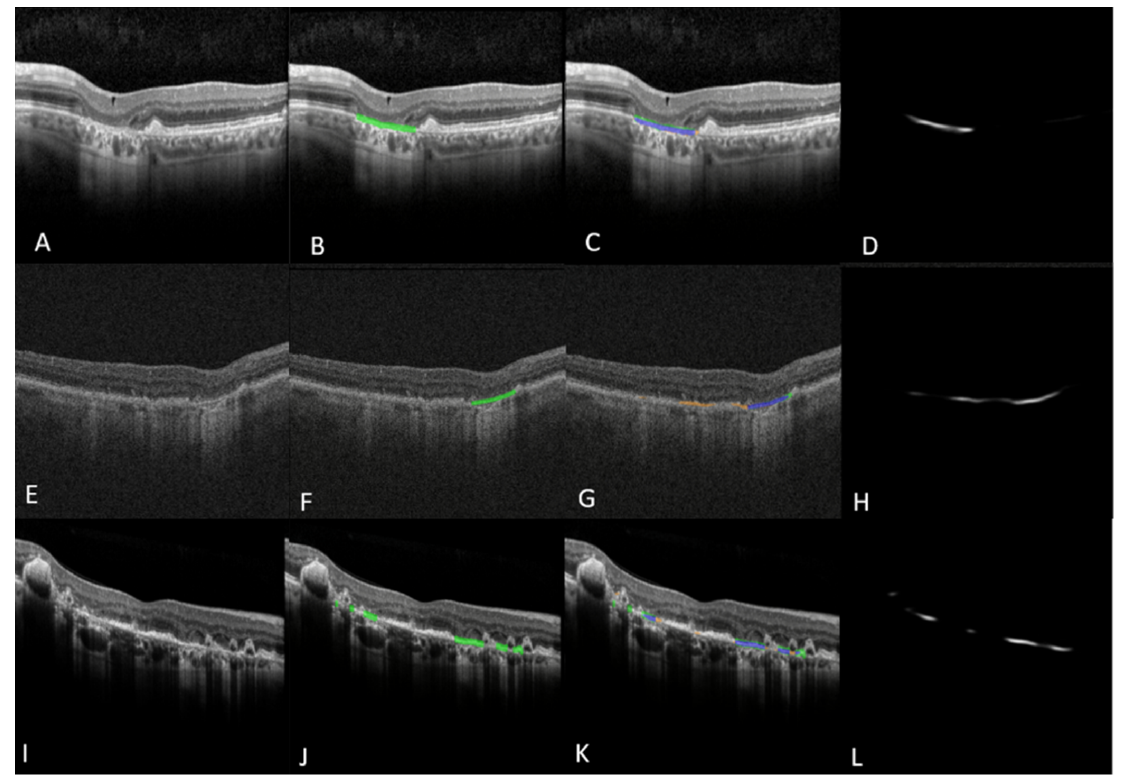
Figure 4. Left panel ( A – D ) shows B-Scan model GA segmentation performance as visualized on individual B-Scans of an OCT volume. ( A ) Raw B-scan from a patient with GA; ( B ) Ground truth mask (indicated in green) generated using multi-layer segmentation and concurrence of EZ, RPE, and BM lines; ( C ) B-scan model output overlay with blue areas indicating correct segmentation of GA area, orange areas indicating false positive segmentation and green areas indicating false negative segmentation; ( D ) Gray-scale output of the B-scan model indicating model confidence. Middle panel ( E – H ) shows an example of false positive segmentation. Right panel ( I – L ) shows an example